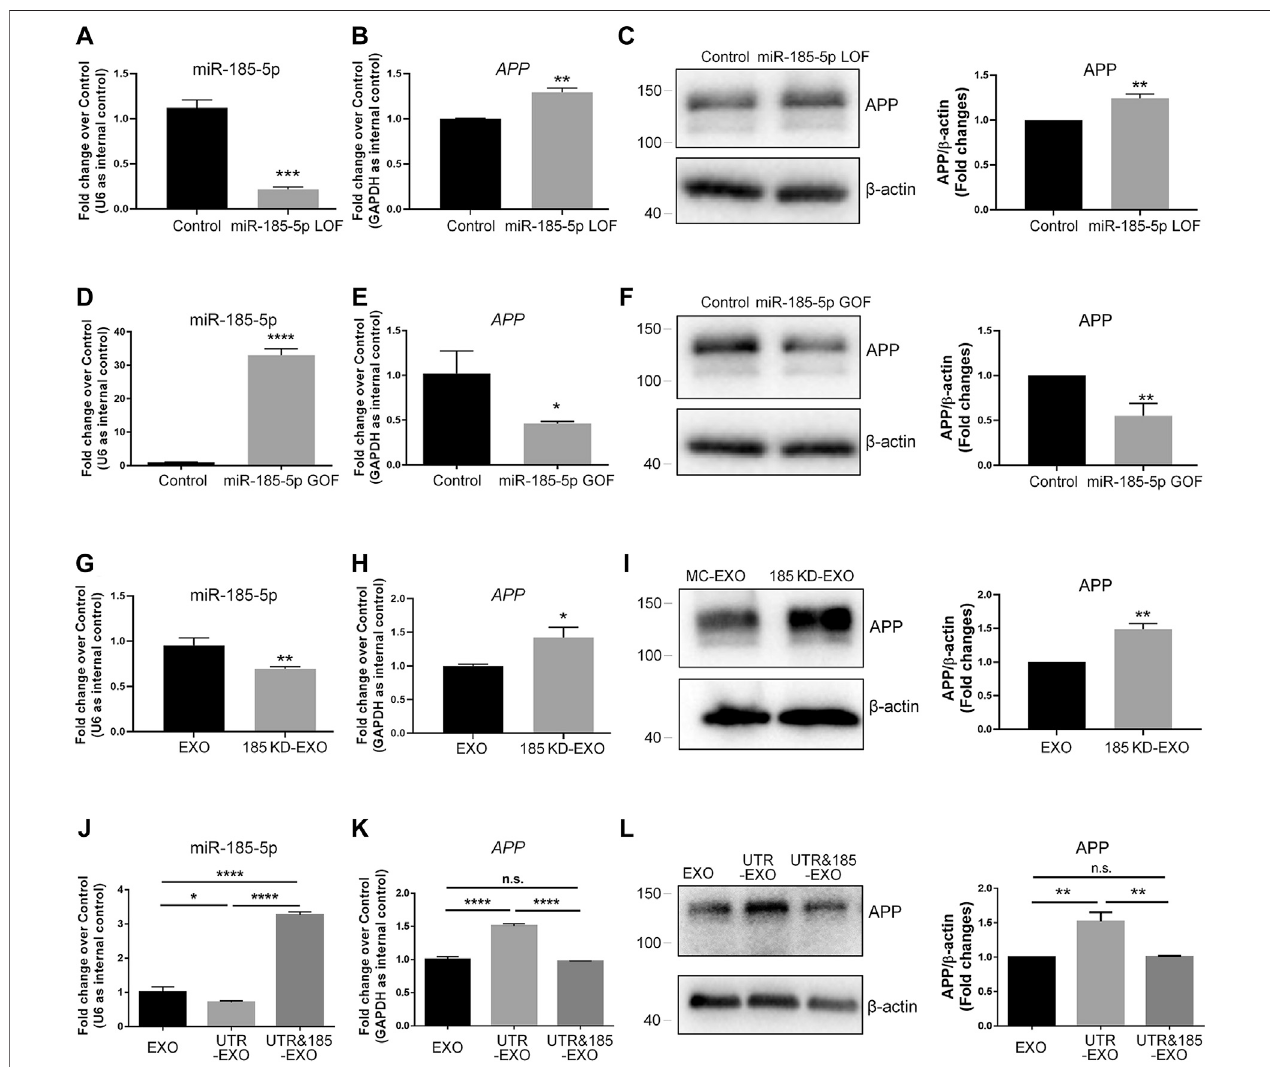
FIGURE6| ExosomalmiR-185-5pisimportanttoinhibitAPPexpressioninrecipientcells. (A) N2acellsweretransfectedwitheitherscrambledcontrolormiR-185- 5p inhibitor for 2 days. The expression levels of miR-185-5p were determined by RT-qPCR. (B) The up-regulation of APP transcriptexpression in miR-185-5p inhibitor- transfectedN2acellsweredeterminedbyRT-qPCR. (C) Theup-regulationofAPPproteinexpressioninmiR-185-5pinhibitor-transfectedN2Acellsweredeterminedby western blotting. (D) N2a cells were transfected with either scrambled control or miR-185-5p mimics for 2 days. The expression levels of miR-185-5p